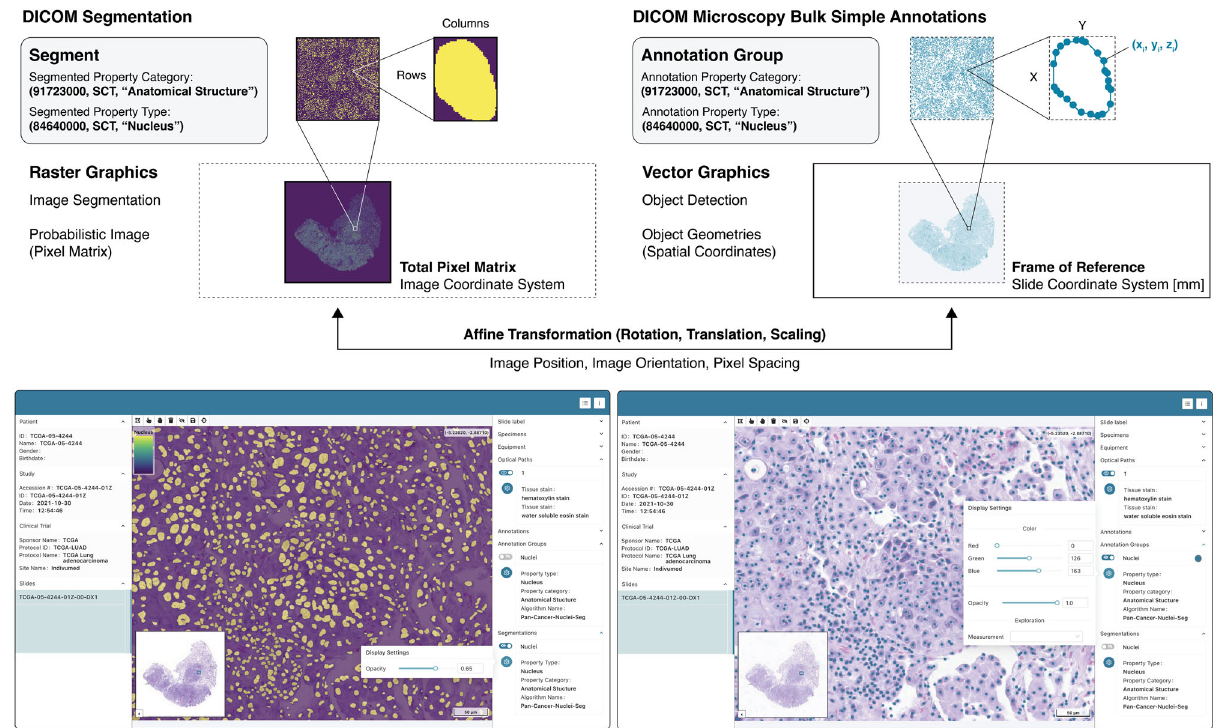
Fig. 7 | Display of image segmentation and object detection results. Schematic representation of image segmentation or object detection results as raster or vector graphics, respectively, together with semantic metadata (top) and screen- shotsof theSlimuserinterface displaying the data (bottom).Shownarethe binary segmentation mask(left)aswellas the centroidsofdetected objects (right), which werederivedfromslidemicroscopyimagesfromTheCancerGenomeAtlas(TCGA)